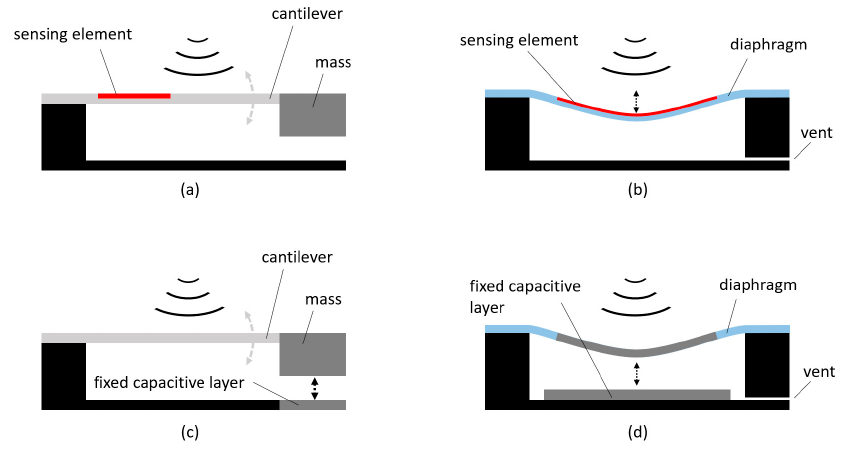
Figure 4 . Common architectures of acoustic and vibration sensors. Panel ( a ) cantilever with embedded sensing element and suspended mass. Panel ( b ) diaphragm with embedded sensing element. Panel ( c ) cantilever with capacitive layers and suspended mass. Panel ( d ) diaphragm with capacitive layers.